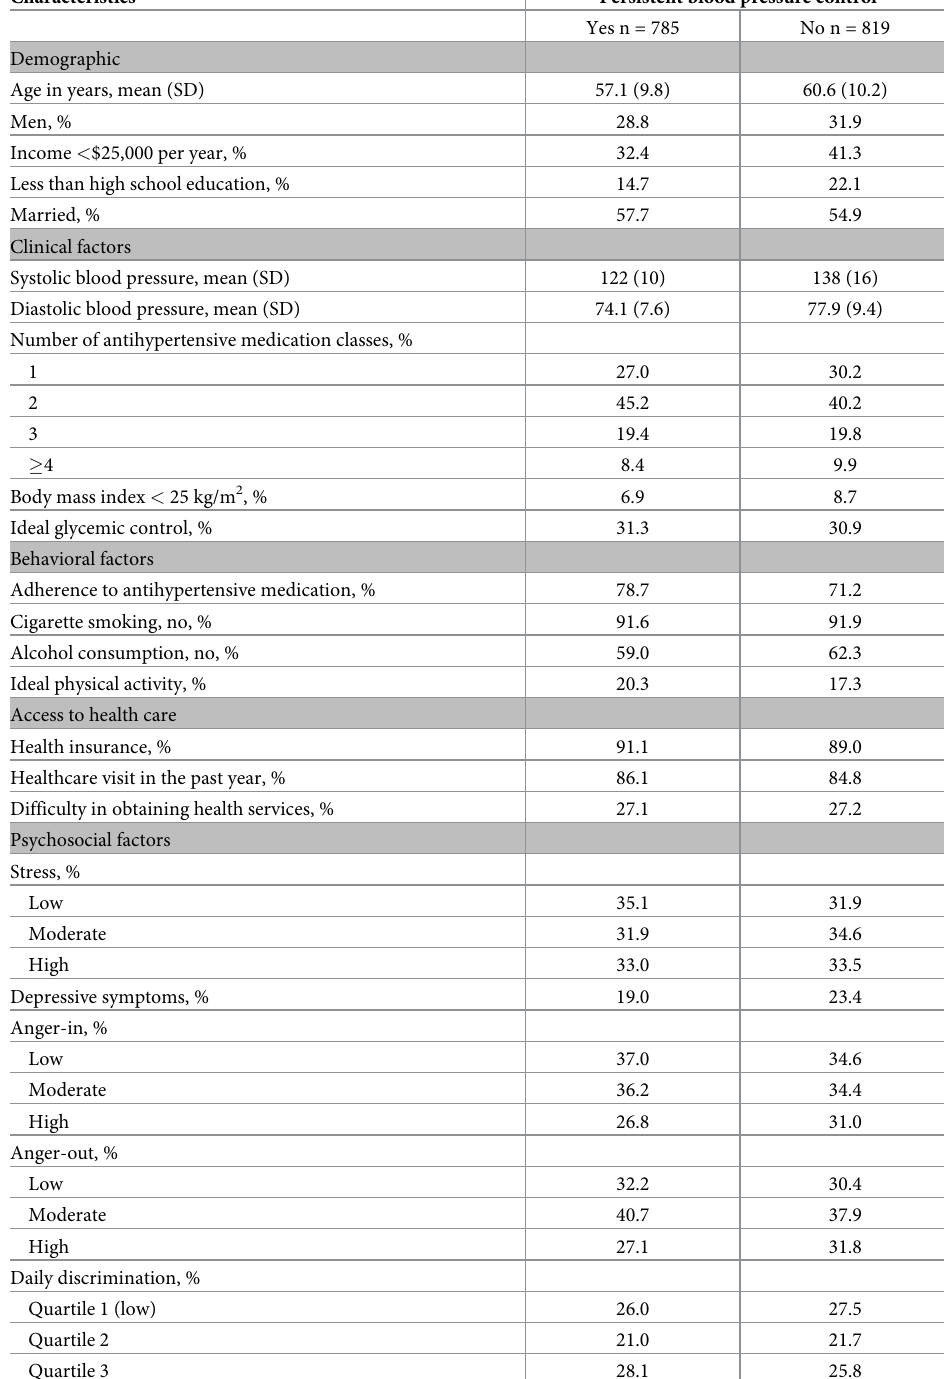
Table 1. Baseline characteristics of Jackson Heart Study participants taking antihypertensive medication by per- sistent blood pressure control status.